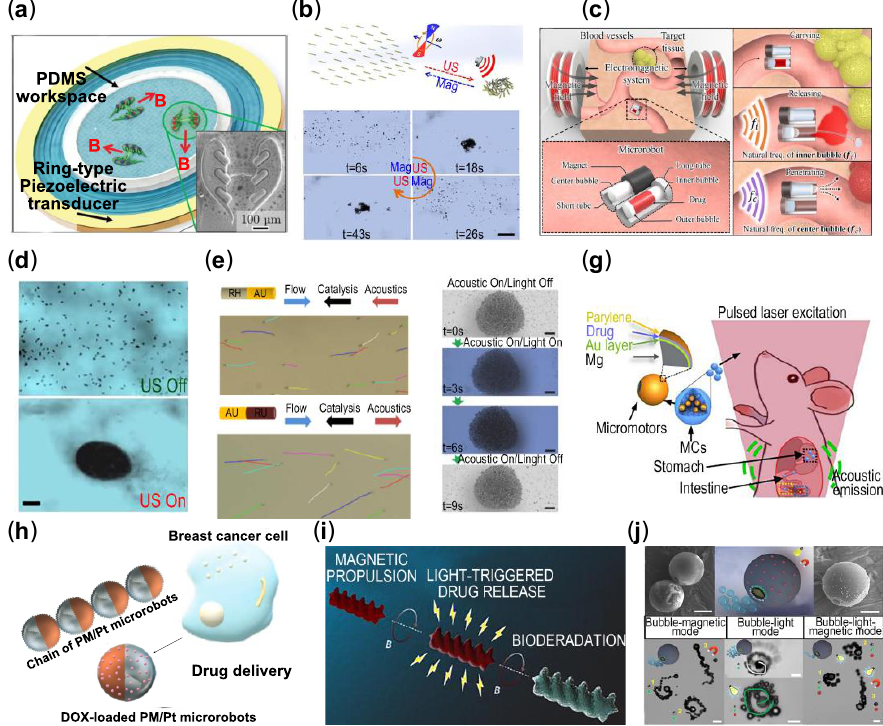
Figure 8. Schematic illustration of hybrid propulsion mechanism and applications. ( a ) Schematic diagram of magneto-acoustic actuation of CeFlowBots: An acoustic actuation test-bed comprising an annular piezoelectric transducer concentrically bonded to a glass substrate with a polydime- thylsiloxane (PDMS)-based ring-shaped workspace on the opposite side [183] (Reproduced with permission from Mohanty et al., Small; published by Wiley, 2022); ( b ) Scheme of reversible assembly of the magnetic-acoustic hybrid nanomotors and snapshots of the directional swarm motion, aggre- gated nanomotor assembly at different times [184] (Reproduced with permission from Li et al., Nano Letters; published by American Chemical Society, 2015); ( c ) Schematic diagram of the de- signed microrobot and drug manipulation process(carrying, releasing, and penetrating) [61] (Re- produced with permission from Jeong et al., Sensors and Actuators A: Physical; published by Else- vier, 2015); ( d ) Microscopic images illustrating the swarming behavior of chemically powered Au−Pt nanomotors under the acoustic radiation forces (scale bar, 10 μm) [67] (Reproduced with permission from Xu et al., Journal of the American Chemical Society; published by American Chemical Society, 2015); ( e ) Directional collective motion of bimetallic micromotors (scale bar, 10 μm) [66] (Repro- duced with permission from Ren et al., ACS Nano; published by American Chemical Society, 2017); ( f ) Time- lapse snapshots of behaviors of Au nanomotors (scale bar, 30 μm) [65] (Reproduced with permission from Zhou et al., Advanced Science; published by Wiley, 2018); ( g ) Schematic of the PAMR in the gastrointestinal tract. The micromotor capsules are administered into the mouse [185] (Reproduced with permission from Wu et al., Science Robotics; published by Amer Assoc Advance- ment Science, 2019); ( h ) Schematic diagram of the fabrication of PM/Pt microrobots for cell manip- ulation, anticancer doxorubicin (DOX) drug loading, and delivery [68] (Reproduced with permis- sion from Villa et al., Advanced Functional Materials; published by Wiley, 2018); ( i ) Schematic dia- gram of the process of light-triggered drug release [70] (Reproduced with permission from Bozuyuk et al., ACS Nano; published by American Chemical Society, 2018); ( j ) Scanning-electron microscopy (SEM) images of the hybrid propulsion modes of microrobots and their track in hydrogen peroxide solutions [186] (Reproduced with permission from Yuan et al., Chemistry of Materials; published by American Chemical Society, 2020). With the combination of acoustic and magnetic fields, the collective behavior of mi- cro/nanoparticles can be applied to targeted drug delivery. A sequential micro/nano-